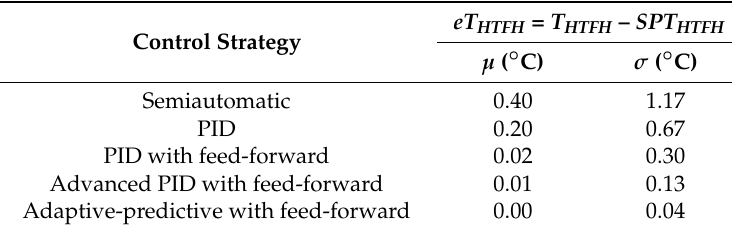
Table 4. TES Discharging Simulation